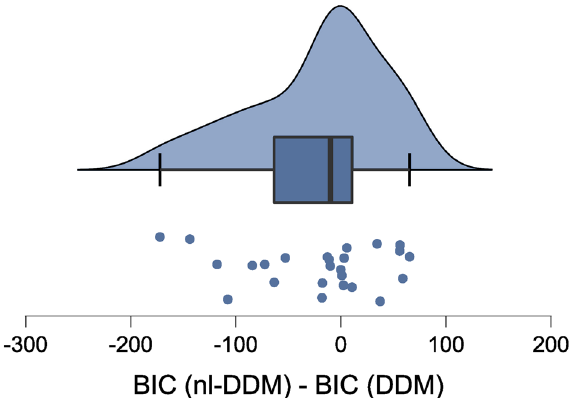
Figure 3. Distribution of the differences between the BIC obtained after fitting the nl-DDM and fitting the DDM on the multi-sensory classification dataset. A more negative difference means a better fit of the nl-DDM compared to the DDM. This figure has been generated using JASP (0.16.0.0) 28 (see https:// jasp- stats.